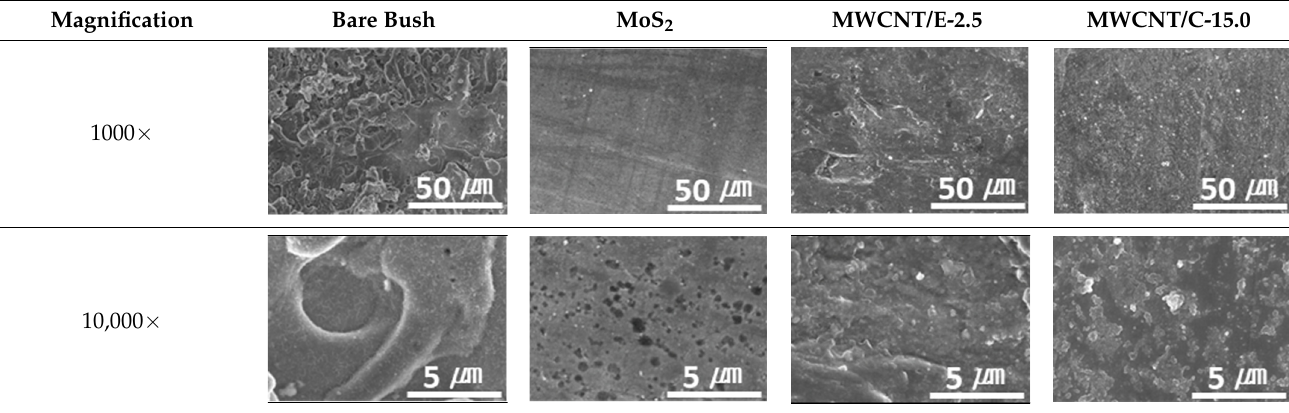
Table 5. Comparison of surface shapes after bush wear according to the addition of MoS 2 and MWCNT.